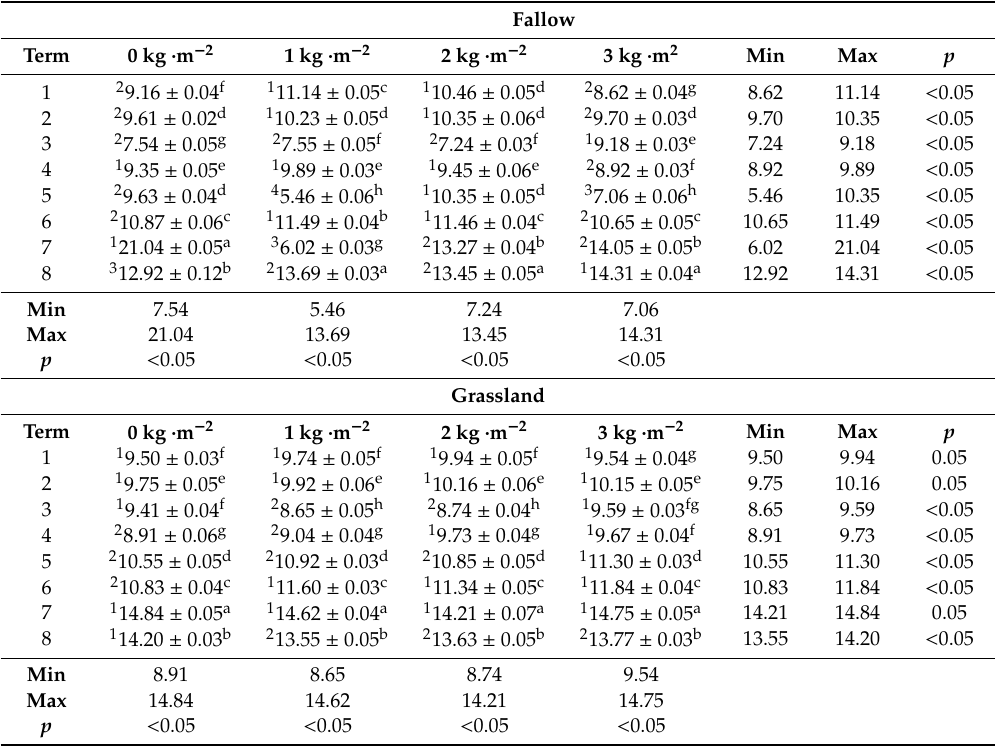
Table 4. Changes in values of total radius of micropore (R, nm) in soil samples collected from fallow and grassland amended with BioC (0, 1, 2, 3 kg · m − 2 ) in terms: 1 st –8 th . Average values from 3 replicates in each term. Other letter designations (a, b, c, d, e, f, g, h) indicate significant di ff erences (between values at p < 0.05) in terms. Other numbers (1, 2, 3) designations indicate significant di ff erences (between values at p < 0.05) among treatments for the same sampling